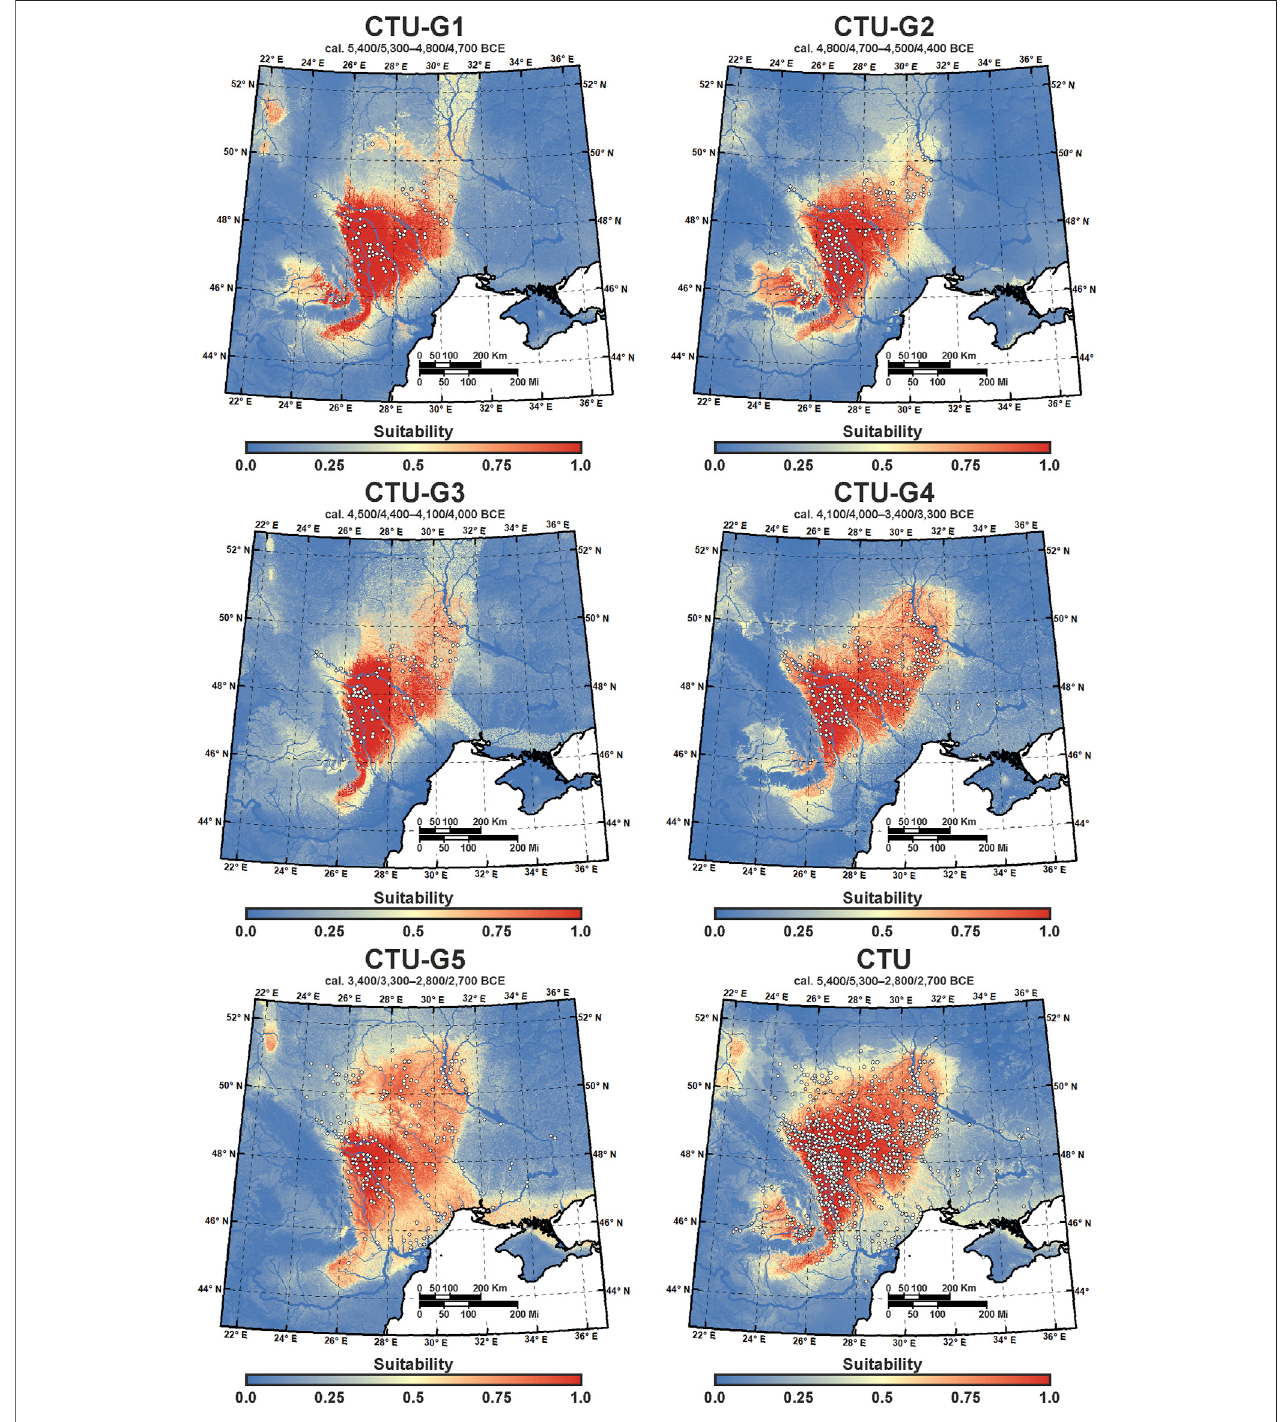
FIGURE 7 | ECNM reconstructions of CTU groups (see Table 1 ) and for the entire CTU culture (cal. 5,400/5,300 – 2,800/2,700 BCE); colors range from blue (0) to yellow (0.5) and to red (1), or low (0%) to middle (50%) and to high (100%) suitability, respectively; the white dots represent the archaeological sites.